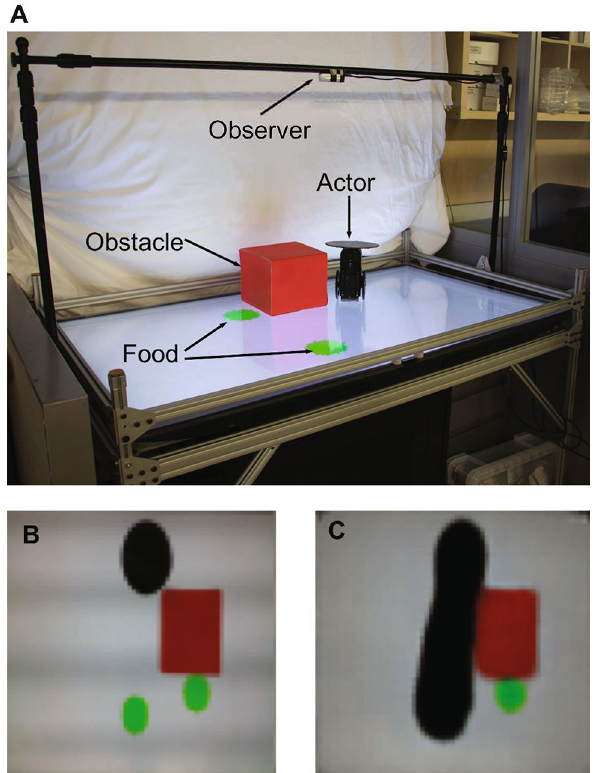
Figure 2. Experimental setup ( A ) Actor robot in playpen, showing observer, green food, and red obstacle. ( B ) A sample input image as seen by the observer, and ( C ) sample output image produced by the observer, which includes a prediction of the motion path of the